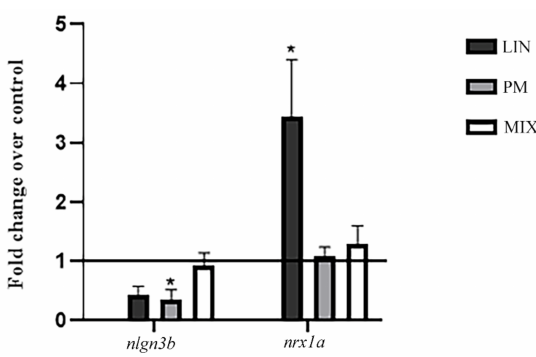
Figure 2. mRNA expression levels of nlgn3b and nrxn1a after exposure of zebrafish larvae to LIN, PM and MIX for 96 hpf. The results are expressed as mean ± SEM. * p < 0.05 vs.